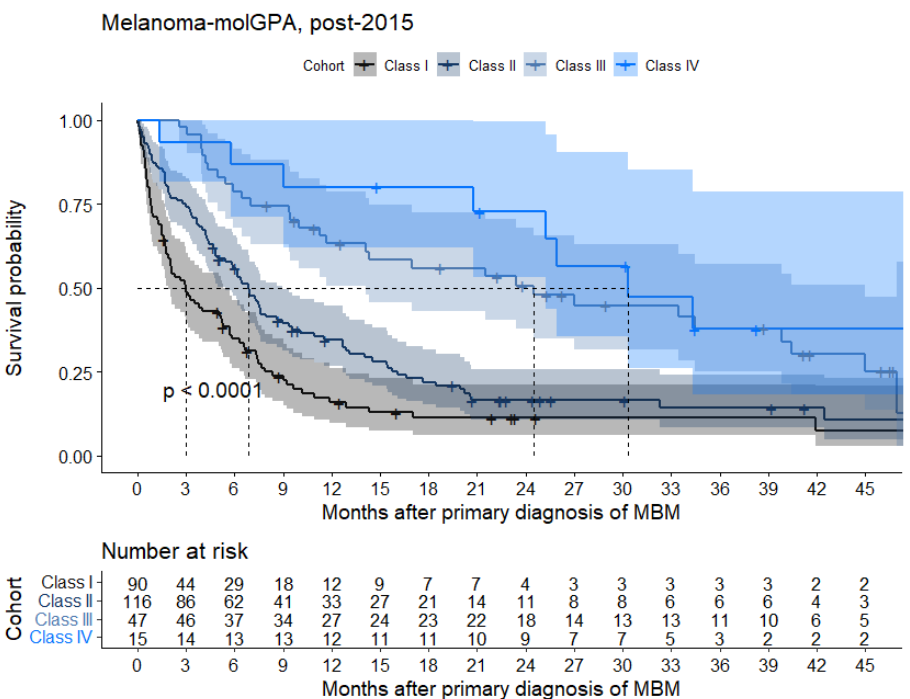
Figure 5. Kaplan–Meier estimates for overall survival of patients diagnosed with melanoma brain metastases (MBM) in the post-2015 cohort of patients with available model input parameters ( n = 268) according to the different prognostic classes (I to IV) of melanoma-molGPA score.